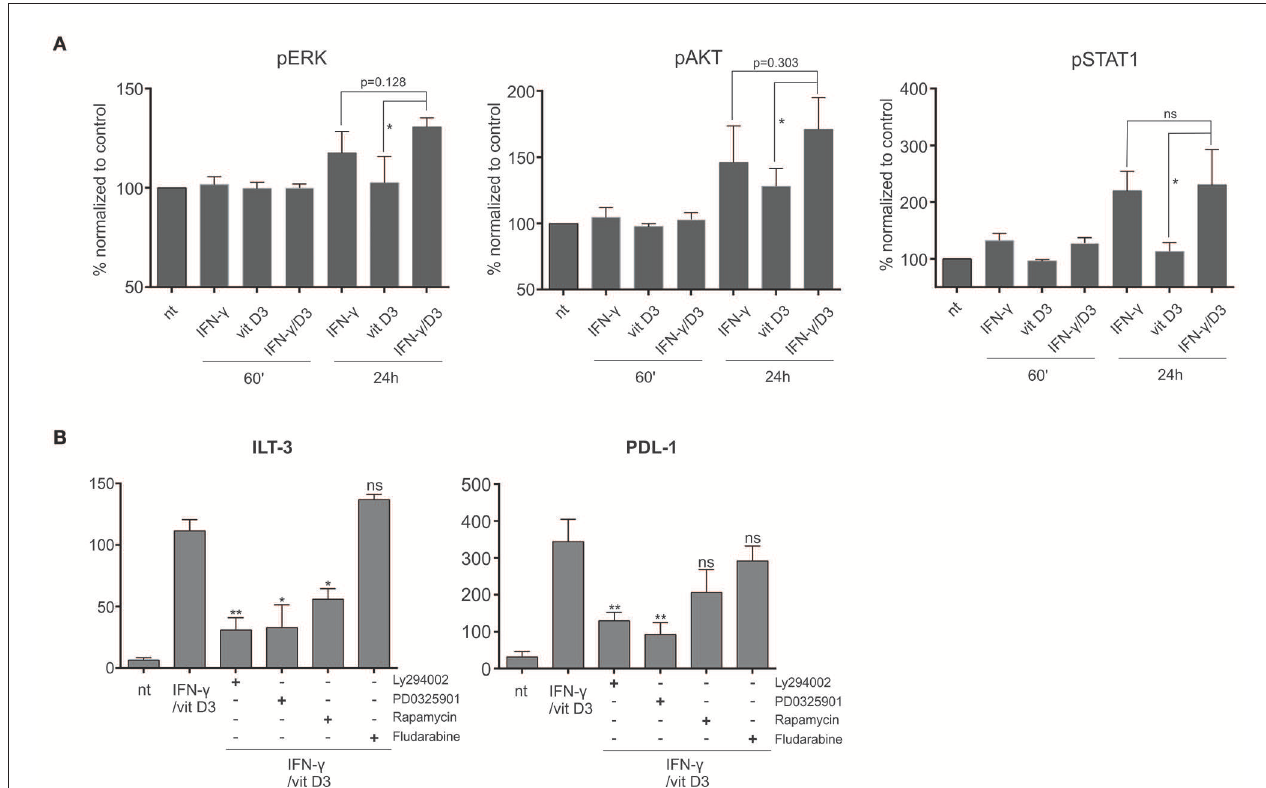
FIGURE 6 | The tolerogenic synergy between IFN- γ and vit D 3 is dependent on MEK/ERK and PI3K/mTOR signaling. (A) The phosphorylation status of ERK, AKT, and STAT-1 signaling proteins was determined. The DCs were stimulated with IFN- γ , vit D 3 , or IFN- γ + vit D 3 . After 1 or 24h, the phosphorylation state of intra cellular proteins was frozen by direct addition of PFA into culture medium. The cells were then permeabilized using ice-cold methanol and stained intracellulary against pERK, pAkt, and pSTAT-1. Results are expressed as % of MFI normalized against untreated controls. Shown is mean ± SD of five independent experiments. (B) Dendritic cells were pre-treated with either inhibitor of PI3K (Ly294002), MEK/ERK (PD0325901), mTOR (rapamycin), or STAT-1 (fludarabine) for 2h. Afterwards, the DCs were stimulated using IFN- γ and vit D 3 , for 24h. After stimulation, the surface expression of ILT-3 and PDL-1 was analyzed. Results are expressed as mean ± SD of four independent experiments. Statistical analysis was performed using Student’s unpaired t -test for determining significance between individual pairs (ns, non-significant; * p < 0.05; ** p <